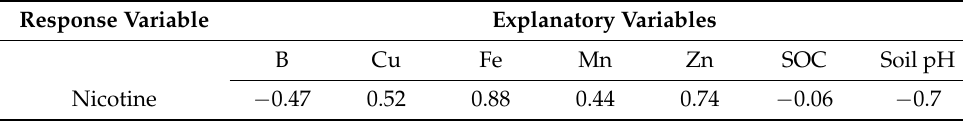
Table 4. Correlations between nicotine and other measured variables in soils. Response